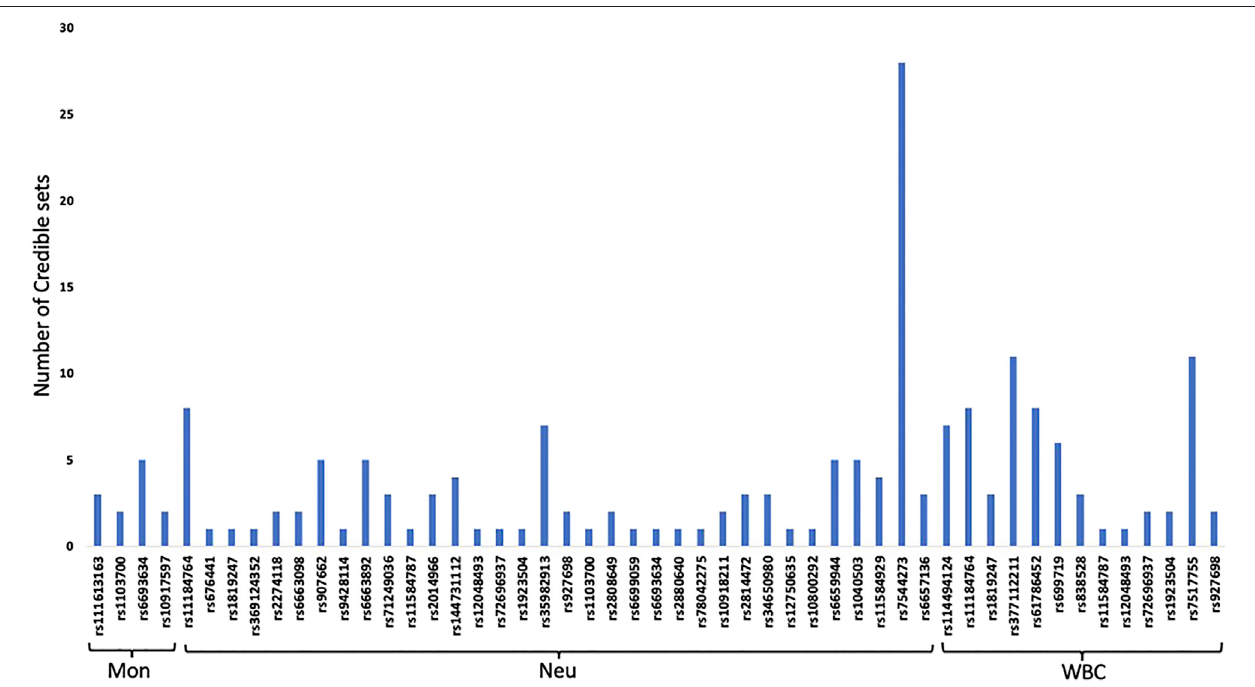
FIGURE 2 | 99% credible set of SNPs that jointly make 99% of the posterior probability of driving each WBC traits.